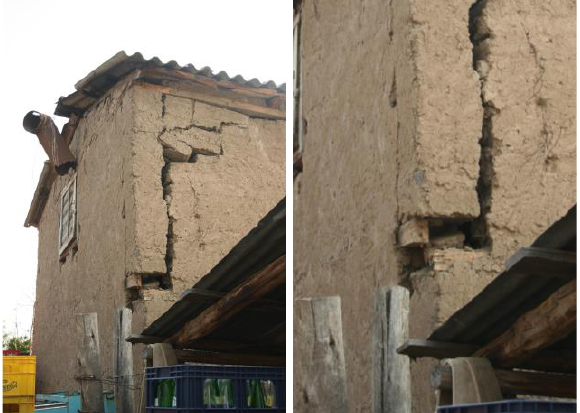
Figure 8. Crack in a furnace in Panguesillo, associated to poor links within its horizontal wooden reinforcement.